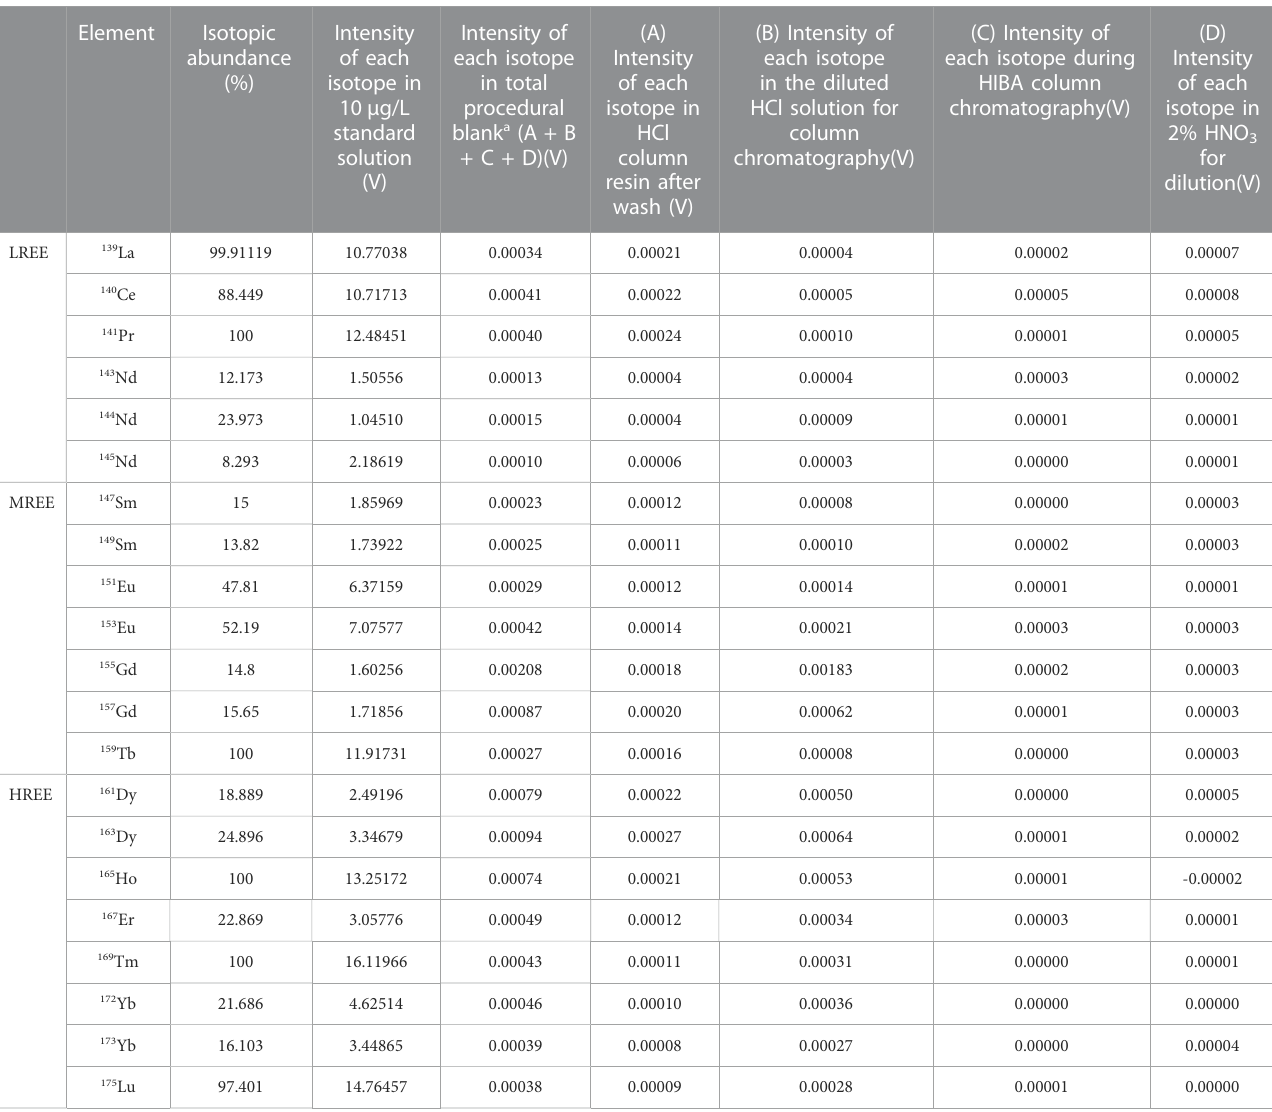
TABLE 4 Total procedural blank and each acid blank during this study.